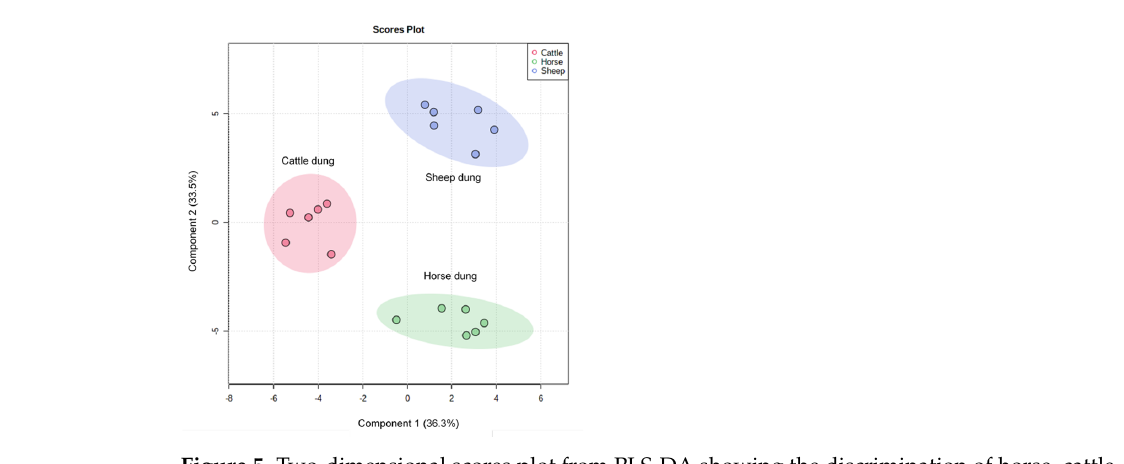
Figure 5. Two-dimensional scores plot from PLS-DA showing the discrimination of horse, cattle, and sheep dung based on their respective GC–MS/QToF profiles. The first and second PCs accounted for 36.3% and 33.5% of the total variation, respectively. Each point in the plot represents a replication. Molecules 2022 , 27 , x FOR PEER REVIEW